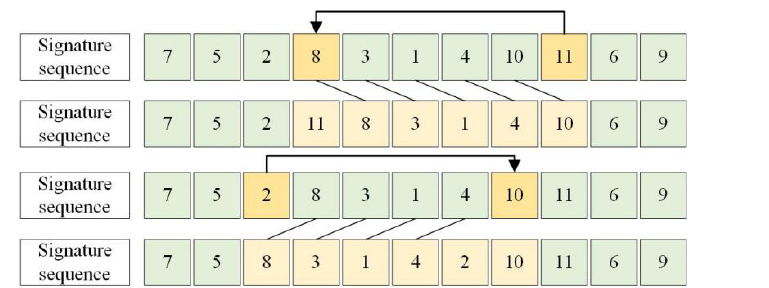
Figure 9. Switch operation, V 1.